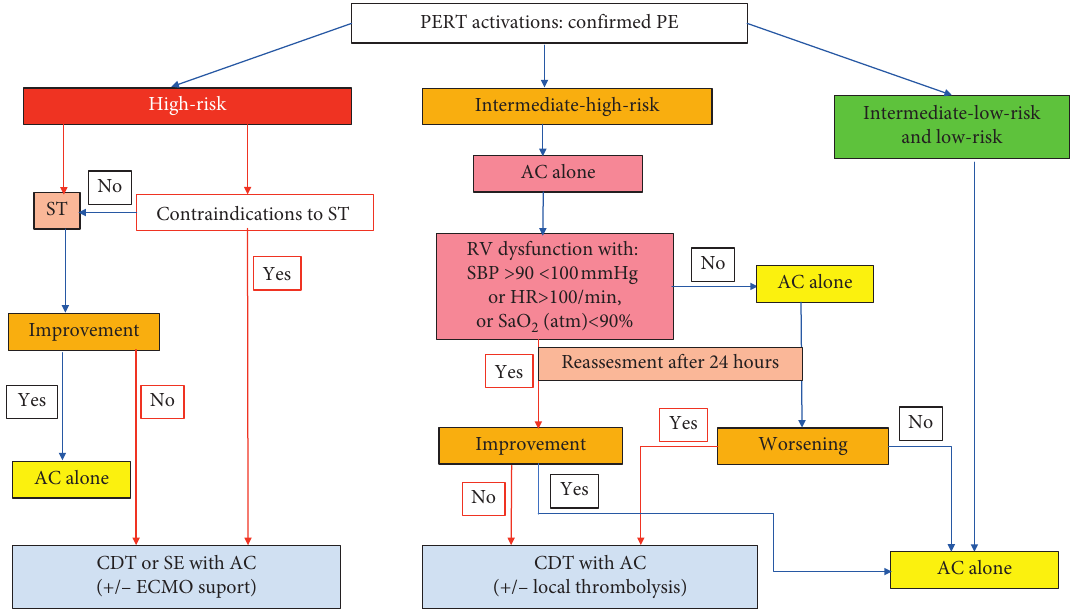
Figure 2: Schematic decision-making approach for PE management and qualification for CDT. AC � anticoagulation, CDT � catheter- directed mechanical aspiration thrombectomy, ECMO � extracorporeal membrane oxygenation, HR � heart rate, PE � pulmonary embolism, PERT � pulmonary embolism response team, RV � right ventricle, SaO 2 � arterial oxygen saturation, SBP � systolic blood pressure, and ST � systemic